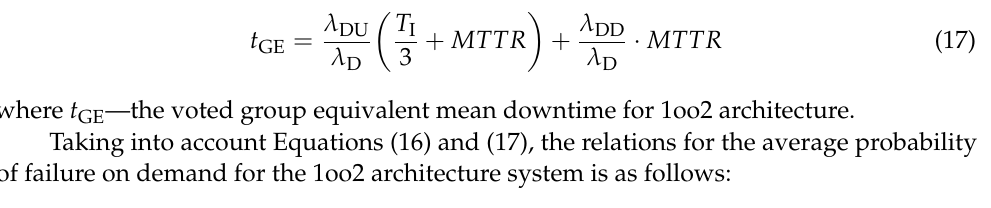
Figure 15. Reliability block diagram for 1oo2 E/E/PE system.